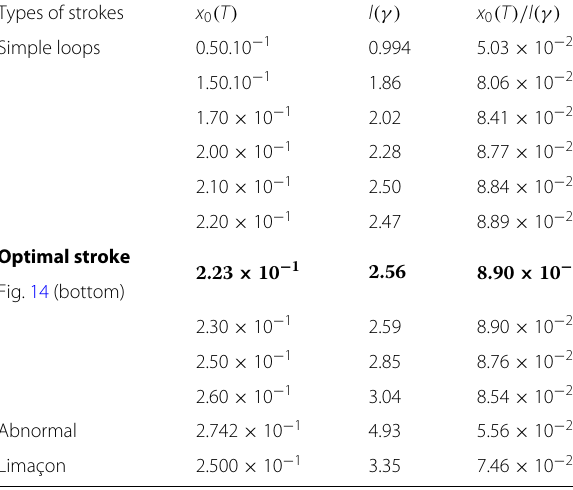
different normal strokes with the mechanical cost Types of strokes Simple